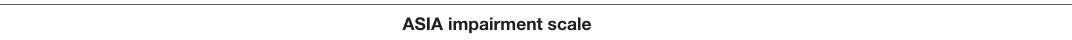
TABLE 2 | ASIA impairment scale (Maynard et al.,